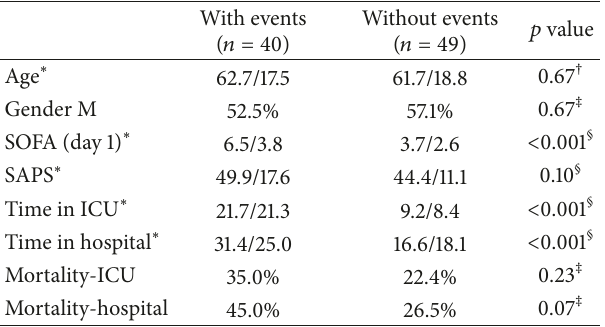
Table 3: Comparison of demographic data and prognostic scores of patients requiring intrahospital transport according to the occur- rence or nonoccurrence of adverse